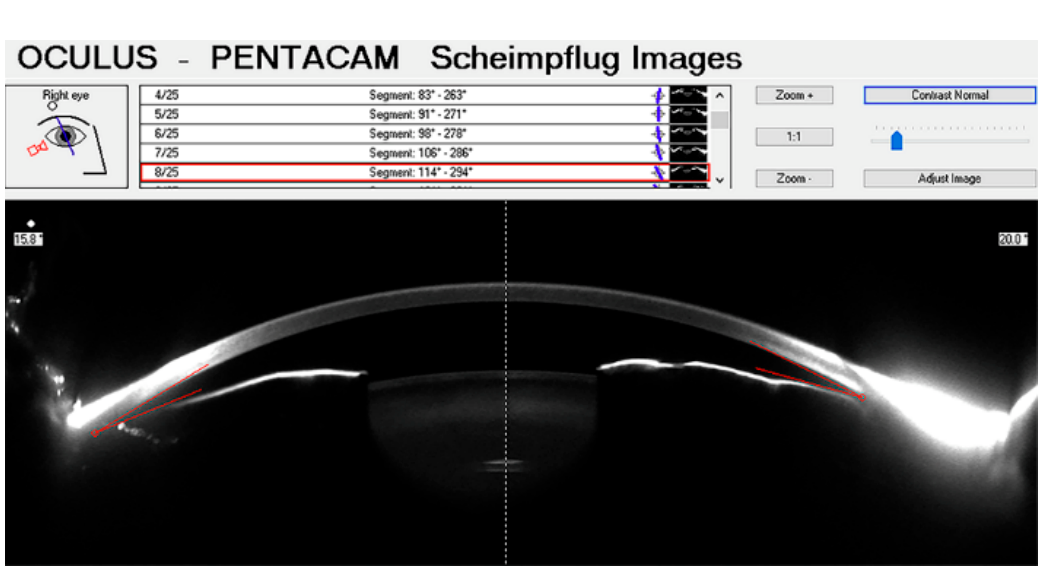
Figure 5. Anterior chamber image acquired with Pentacam, and quantitative measurements provided by the built-in